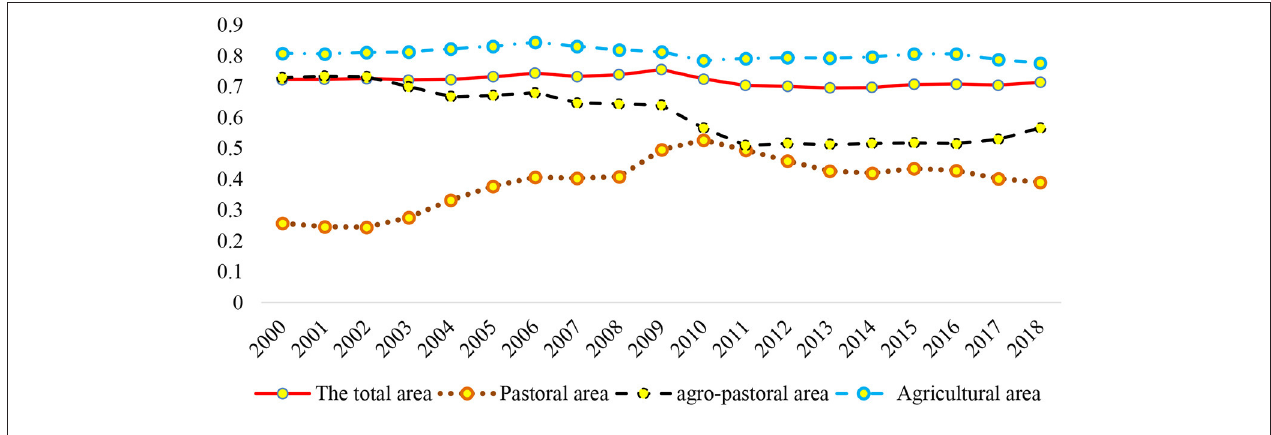
FIGURE 5 | δ convergence result.